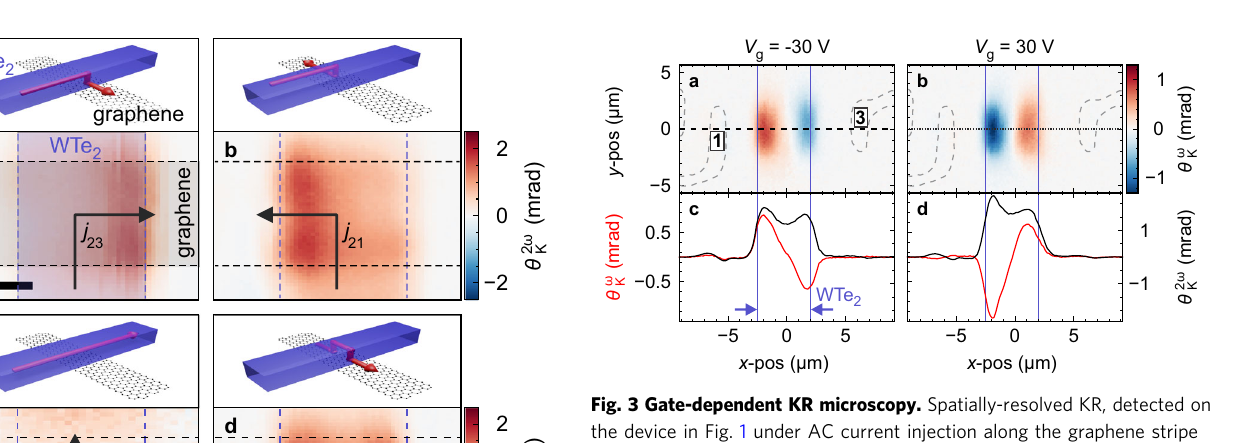
Fig. 1 Optical KR microscopy and graphene transfer curves. a Optical microscope image of a heterostructure comprised of graphene (black dashed line), WTe 2 (blue dashed line) and hBN capping on a back-gated Si/SiO 2 substrate. The WTe 2 crystallographic axes are indicated. The overlay shows the current-induced KR signal at the junction using a colour code as in Fig. 3, for a current applied between the contacts labelled 1 and 3. Scale bar, 5 μ m. The probed area is marked by the shaded rectangle. b An oscillating current j 13 at frequency ω is applied along the graphene stripe. At the heterojunction, the current-induced out-of-plane spin component (red and blue arrows) is locally read-out by a polar KR measurement at frequency ω . The effect of Joule heating is detectable at twice the oscillation frequency 2 ω . c Two-terminal resistance R ω of the graphene stripe measured between contacts 1 and 3 of 13 ; 13 the device in a using an AC voltage V ω that increases stepwise up to 1.5 V. The gate voltage V g was applied to the silicon back contact. The two Dirac 13 points reveal different doping levels (see inset) for the bare graphene leads (charge neutral) and the proximitized graphene ( p -doped).